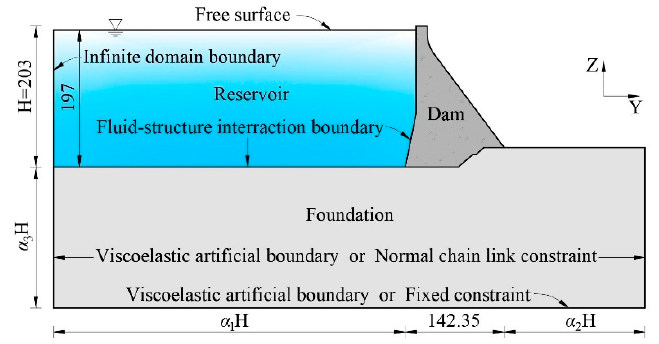
Figure 7. Overview of the dam–foundation–reservoir system (m).